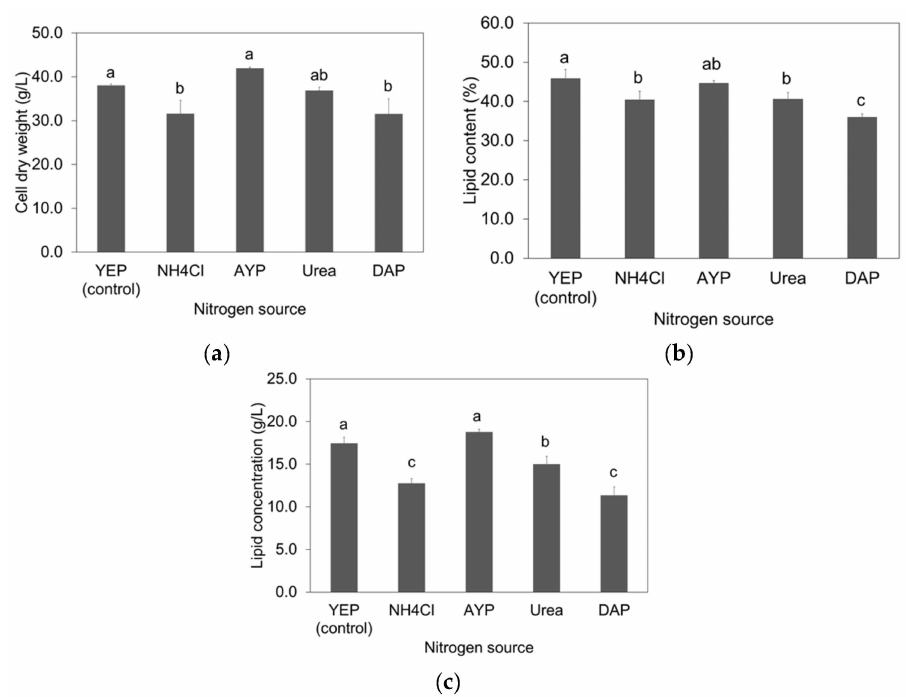
Figure 9. Cell dry weight ( a ), lipid content ( b ) and lipid concentration ( c ) when culturing R. glutinis TISTR 5159 in bagasse hydrolysate mixed with 10% glycerol at C/N molar ratio of 27 in different nitrogen sources for 192 h. Different letters above the bars indicated significant differences in mean values at 95% confidence level.